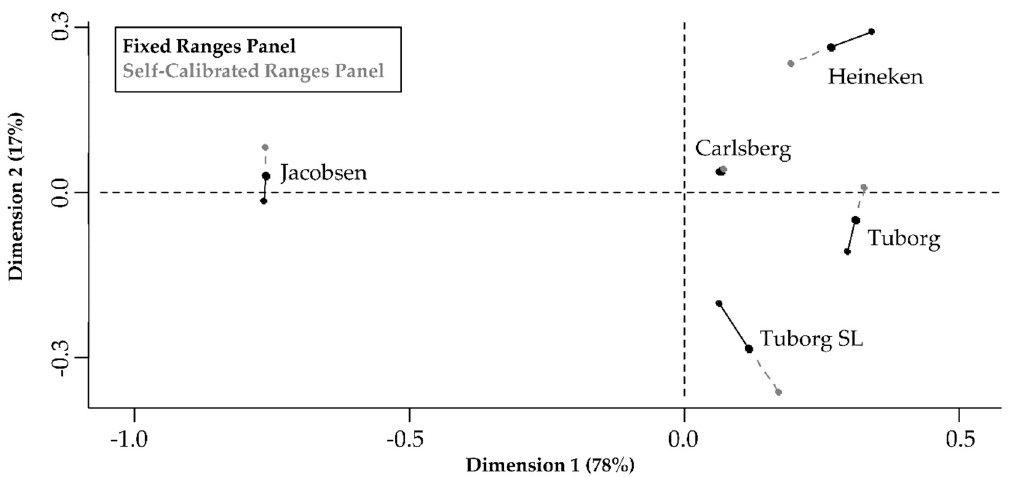
Figure 2. Generalised Procrustes Analysis plot for the positioning of the beers in the sensory space by the two panels.